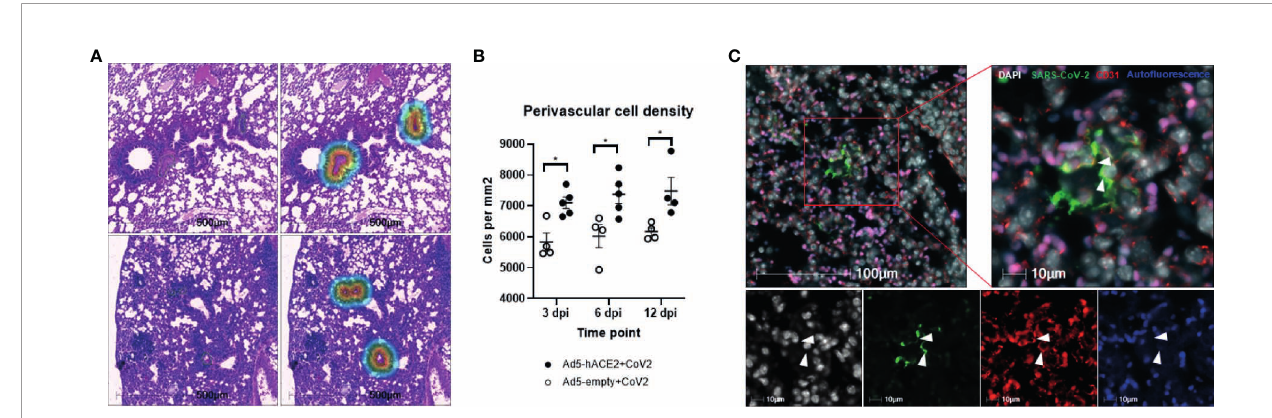
FIGURE 1 | Perivascular in fl ammation and infection of pulmonary ECs by SARS-CoV-2 in Ad5-hACE2 mice. (A) Perivascular in fl ammation in both Ad5-empty (top images) and Ad5-hACE2 mice (bottom images) 3 days post infection (dpi). Control Ad5-empty mice have lower numbers of nucleated cells compared to Ad5-hACE2 mice. The mask of the in fi ltration analysis (top right and bottom right) shows the 100 m m interface surrounding the tunica adventitia where the cell density was quanti fi ed: 5,461 cells/ m m (top right) and 8,775 cells/ m m (bottom right). (B) Quanti fi cation of perivascular in fl ammation of SARS-CoV-2 (CoV-2) infected mouse lungs on 3, 6, and 12 dpi. Perivascular in fl ammation was quanti fi ed by the density of nucleated cells within 100 m m of the tunica adventitia of small arterioles, n = 4-6 for each time point per group. * indicates P<0.05 using two-tailed, unpaired t-test. (C) Representative immunostaining images showing co-localization (arrowhead) of SARS-CoV-2 proteins with CD31 in the lung of infected Ad5-hACE2 mice on 3 dpi. Auto fl uorescence (blue) differentiates red blood cells which fl uoresce in the 488 (green), 568 (red), and 647 (blue) channels. Green: SARS-CoV-2; white: DAPI; red: CD31; blue: auto fl